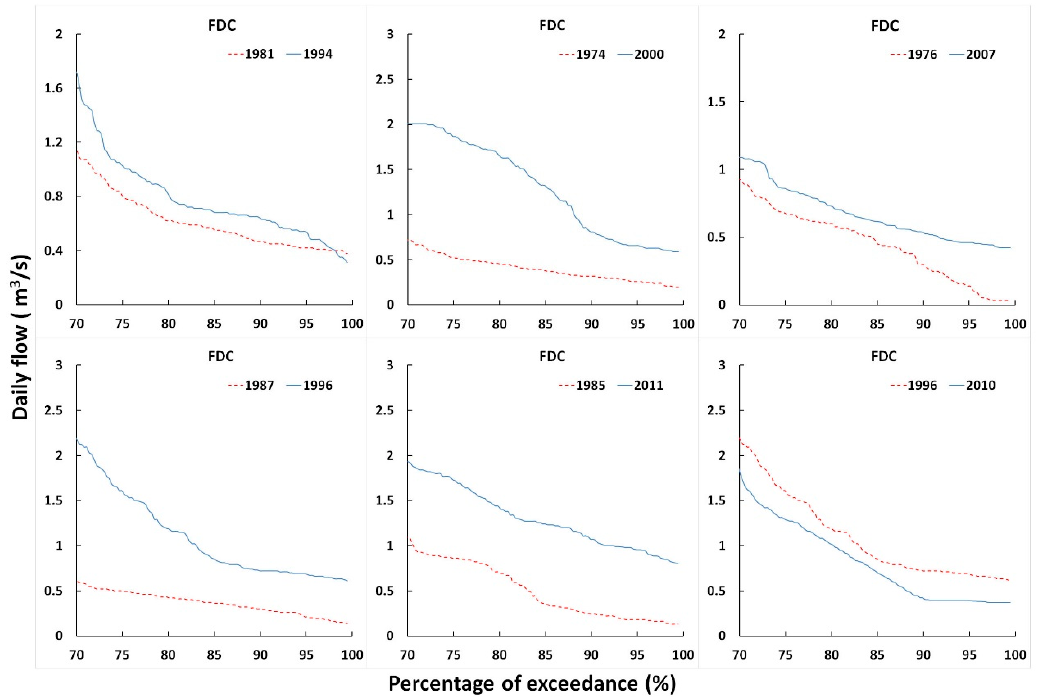
Figure 8. The selected paired years for low flow: 1981 vs 1994 (Period 1 vs Period 2) ( a ), 1974 vs 2000 (Period 1 vs Period 3) ( b ), 1976 vs 2007 (Period 1 vs Period 4) ( c ), 1987 vs 1996 (Period 2 vs Period 3) ( d ), 1985 vs 2011 (Period 2 vs Period 4) ( e ), 1996 vs 2010 (Period 3 vs Period 4) ( f ).